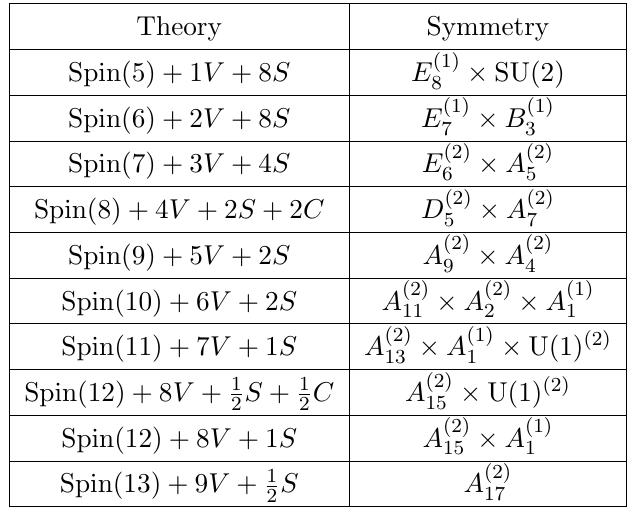
Table 1. The minimal symmetry consistent with the perturbative plus 1-instanton contribution for the 5 d Spin gauge theories considered here. The spectrum of the expected additional current is such that it can only be accommodated by an a(cid:14)ne group, at least for some factors of the global symmetry. This is interpreted as the theory lifting to a 6 d SCFT in the in(cid:12)nite coupling limit, whose symmetry is the (cid:12)nite Lie group associated with the a(cid:14)ne case. The superscript here denotes whether the a(cid:14)ne group is the twisted (2) or the untwisted version (1). This lifts to whether the compacti(cid:12)cation of the 6 d SCFT involves a twist or not. We also use the notation of U(1) (2) for a U(1) group projected out by charge